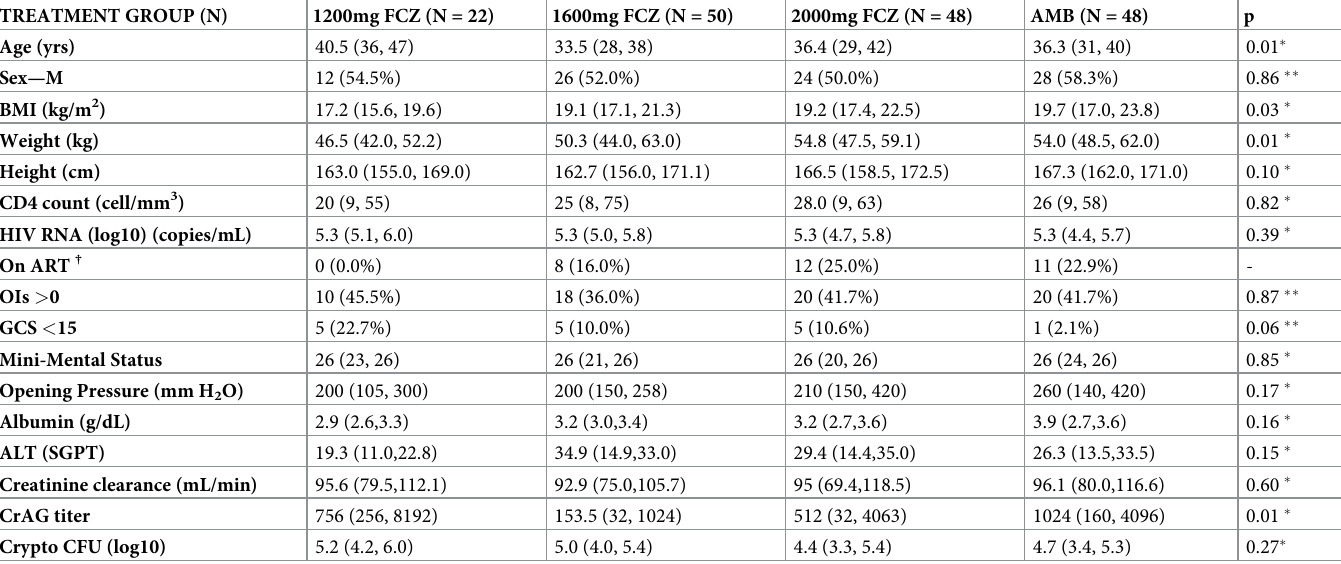
Table 2. Baseline demographic, clinical and laboratory